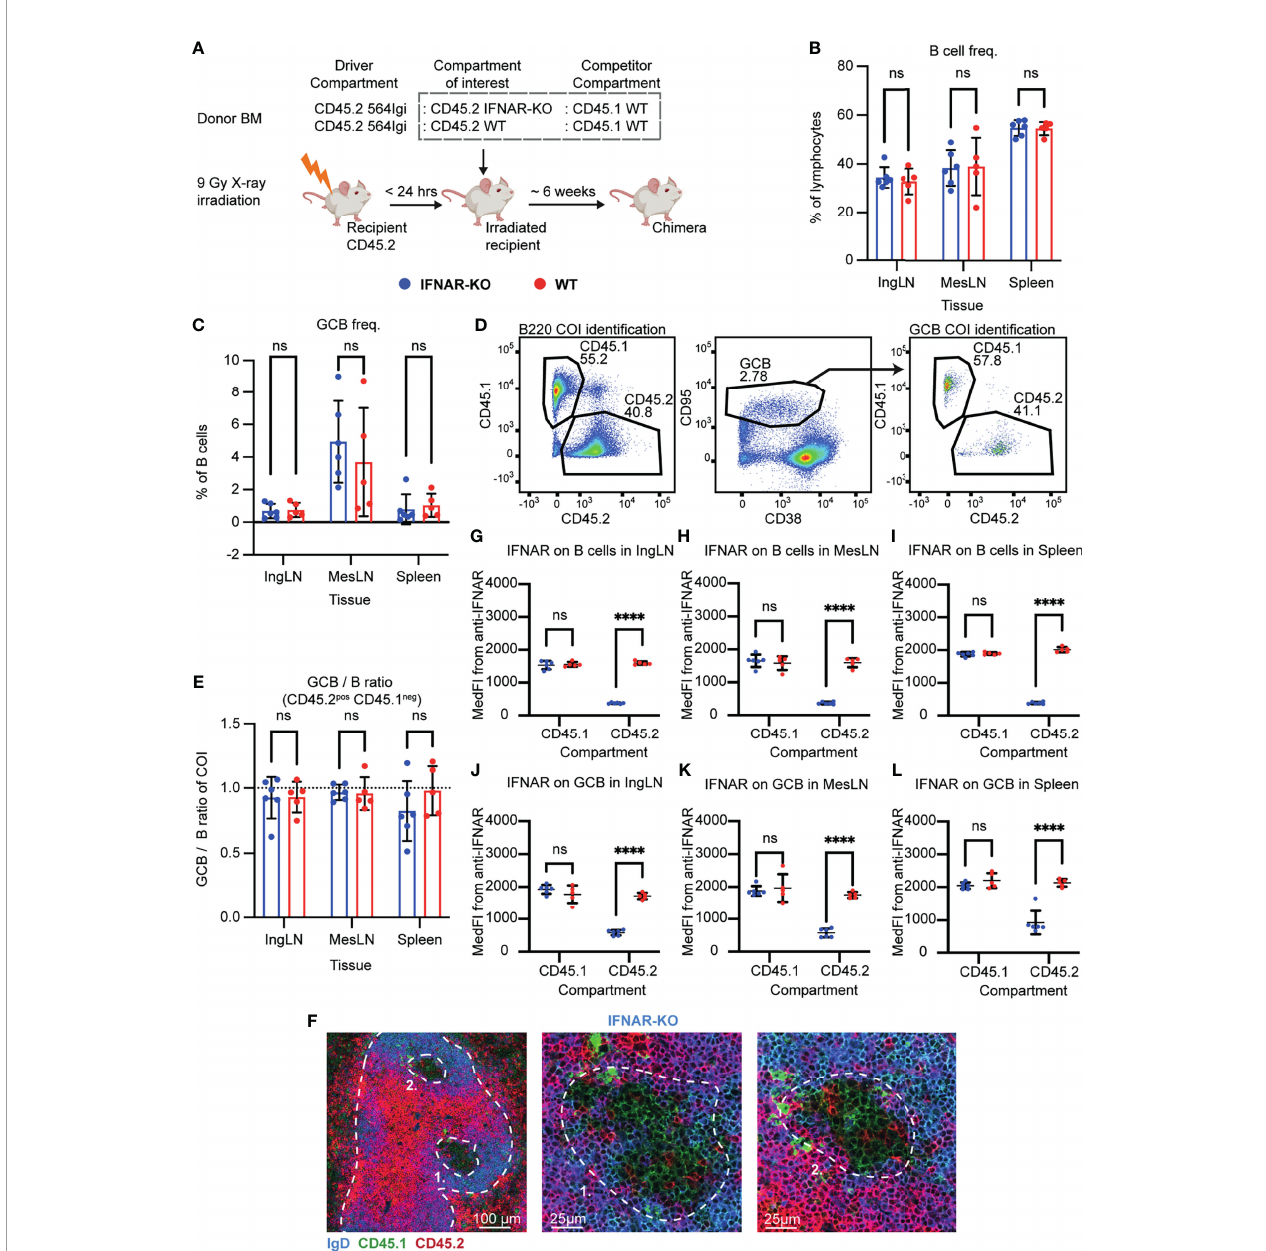
FIGURE 1 | B cell intrinsic IFNAR signaling is not required for autoreactive germinal center participation. (A) Schematic overview of experimental setup with timeline. (B) B cell frequencies out of live, singlet lymphocytes, in lymphoid tissues of IFNAR-KO (blue, n = 6) and WT (red, n = 5) chimeras. Each dot represents an individual mouse and bars indicate mean +/- SD, with statistical signi fi cance given for two-way ANOVA followed by Sidak ’ s post-test ( a = 0.05), ns = not signi fi cant. (C) As in (B) , but for GCB cell frequencies instead. (D) Representative example from an IFNAR-KO chimera showing gates used to de fi ne CD45.2 vs. CD45.1 within the B cell (left) and GCB cell (right) compartments, and the parent GCB cell gate (center). (E) As (B) , but showing relative GCB to B cell ratios for the compartment of interest (COI, CD45.2 + CD45.1 - ). (F) Confocal micrographs of spleen sections from a representative IFNAR-KO chimera stained for IgD (naïve B cells, blue), CD45.1 (green), CD45.2 (red) and the marginal zone (CD169, not shown). Left, lower magni fi cation image, with indication of the marginal zone (broken white line, based on CD169 staining, Figure S1J ) and two GCs (numbered). Center and right panels, higher magni fi cation images of the two GCs identi fi ed in the left panel. Channel assignments and brightness were adjusted to enhance visual clarity of micrographs. (G) Median fl uorescence intensity of IFNAR on CD45.1 and CD45.2 B cells in inguinal lymph nodes of IFNAR-KO (blue, n = 6) and WT (red, n = 5) chimeras. Each dot represents an individual mouse and bars indicate mean +/- SD, with statistical signi fi cance given for two-way ANOVA followed by Sidak ’ s post-test ( a = 0.05). ns = not signi fi cant, **** = p<0.0001. (H) as for (G) , but for B cells in mesenteric lymph nodes. (I) as for (G) , but for B cells in the spleen. (J) as for (G) , but for GCB cells in inguinal lymph nodes. (K) as for (G) , but for GCB cells in mesenteric lymph nodes. (L) as for (G) , but for GCB cells in the